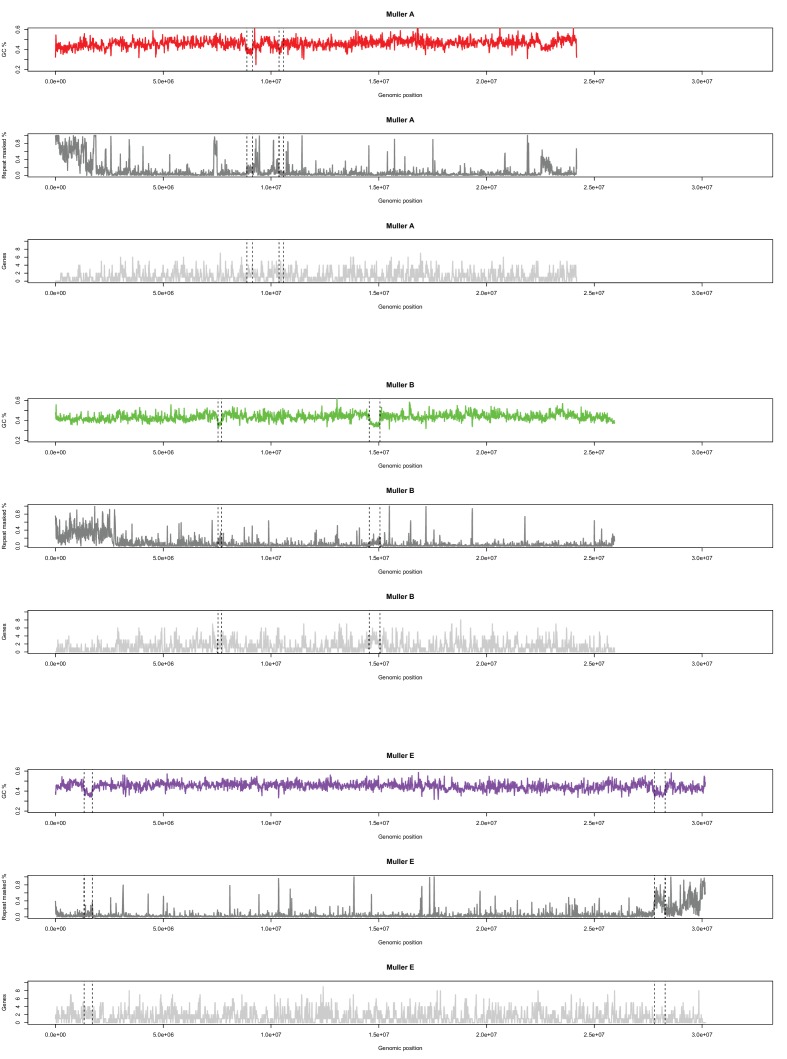
GC-content, the percentage of bases repeat-masked, and number of genes, in 10 kb non-overlapping windows across Muller A, B and E.Seed regions are shown bounded by dashed lines. Note the orientation for the Muller elements are shown as in Figure 5B.